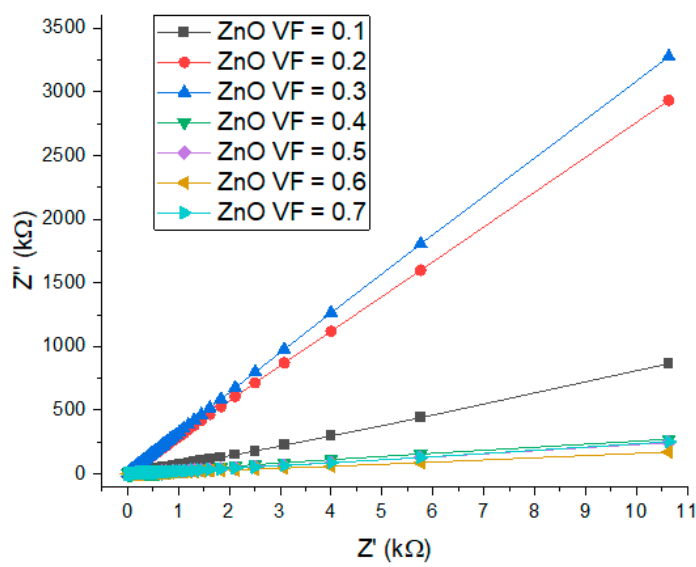
Figure 10. Nyquist plot for the composite samples for each volume fraction of ZnO with a change of frequency from 20 Hz–20 MHz.